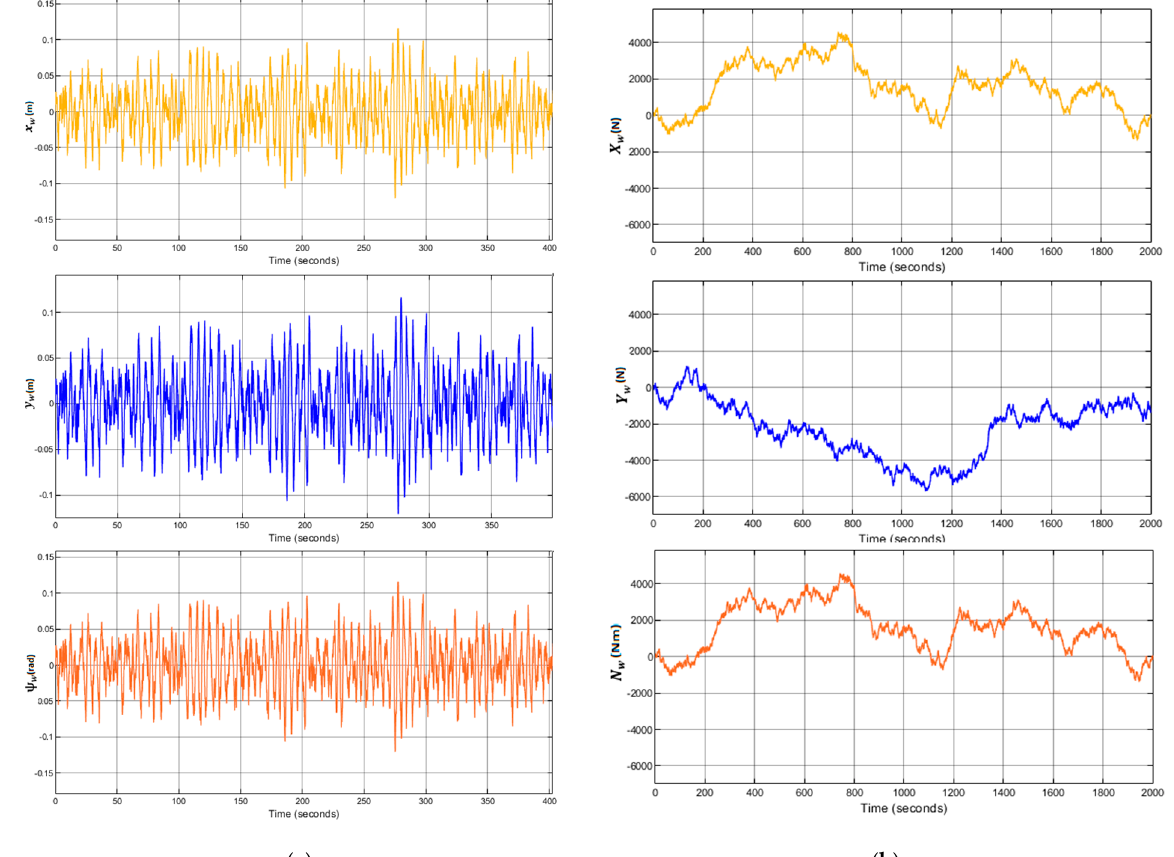
Figure 5. ( a ) Systems with LQG controller control results with waves. First-order waves forces and moments applied to the caisson. ( b ) Second-order waves forces and moments applied to the caisson.